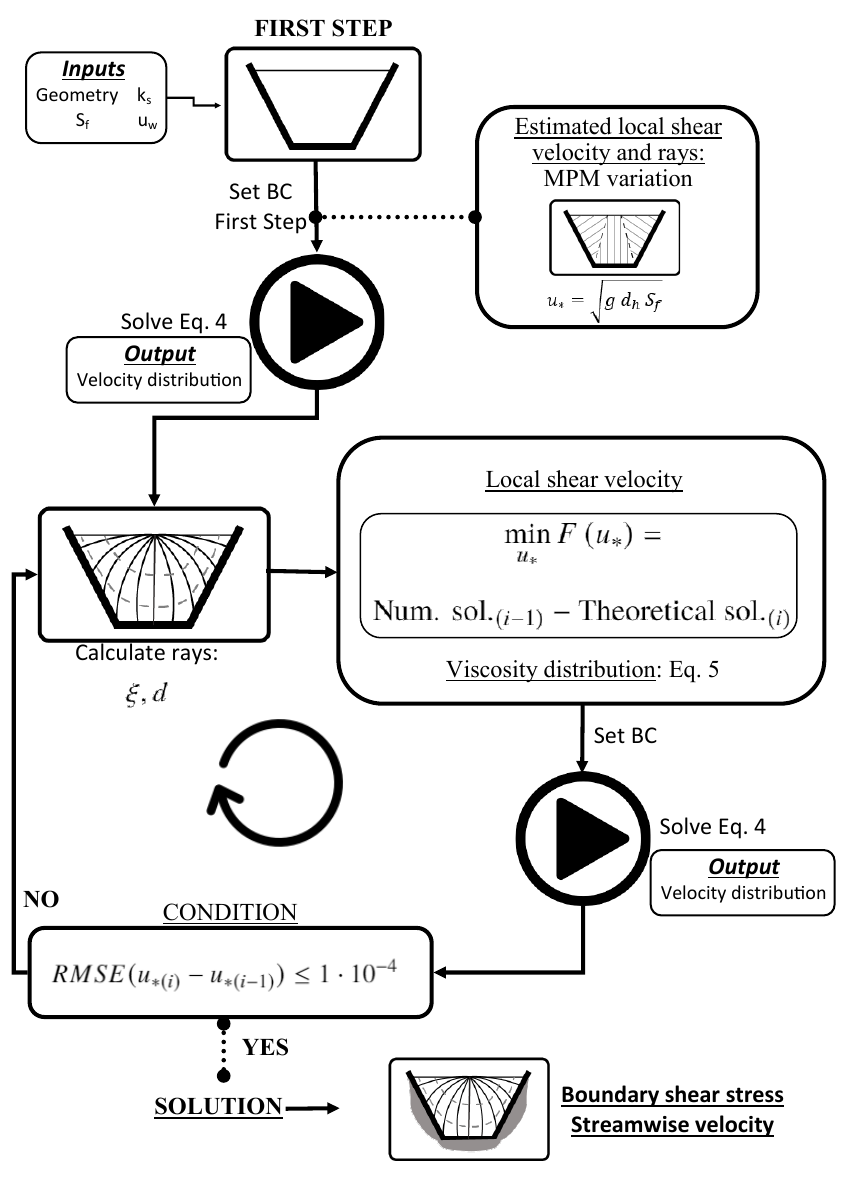
Figure 5. Flow diagram of the computation